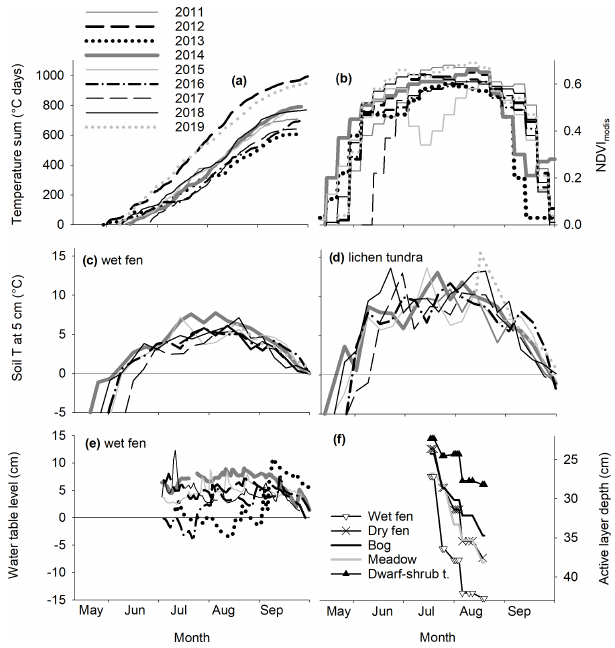
Figure 2. (a) Air temperature accumulation with the threshold T air and surface T soil of 0 ◦ C, (b) seasonal dynamics of NDVI in the study area (16d MODIS data), (c) weekly means of soil temperature at a depth of 5cm in wet fen and (d) in lichen tundra, (e) water-table level relative to the ground surface in wet fen, and (f) LCT-specific means of thaw depth in the measurement collars in 2014. Rocks in the ground prevented detecting the thaw depth of lichen